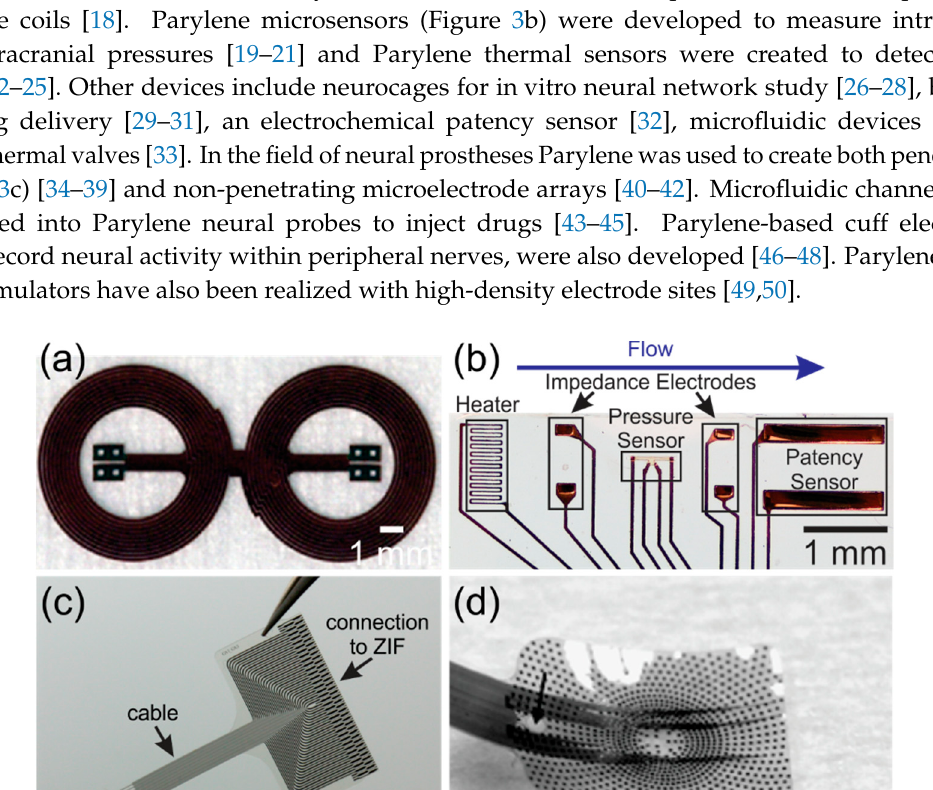
Figure 2. Cross section of a typical device showing insulated and exposed metal features, such as traces and electrodes, respectively.